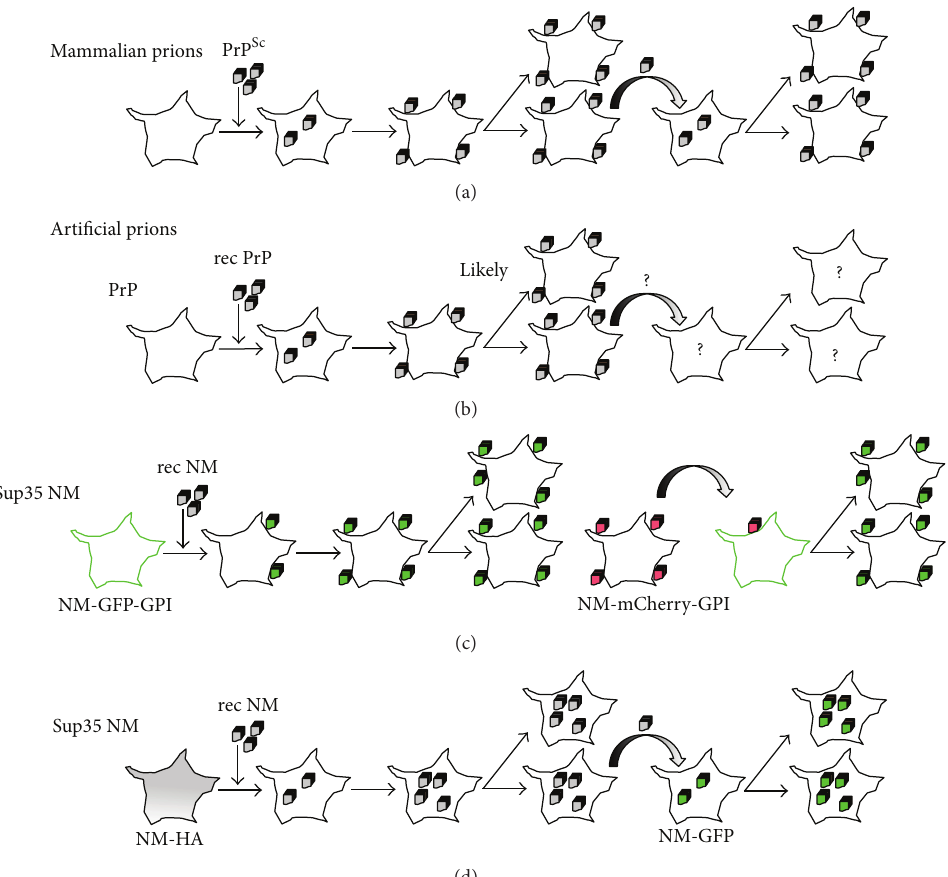
Figure 1: Induction of a PrP or Sup35 NM prion phenotype in mammalian cells. (a) Mammalian prions can infect selected cell cultures. Exposure of permissive cells to brain homogenate containing PrP Sc leads to infection of cells. Prions persist mainly through stable inheritance of PrP Sc aggregates by daughter cells. Prions also spread to adjacent cells by cell-to-cell contact or exosomes and induce productive infection in recipient cells. (b) Artificial prions produced in vitro from recombinant prion proteins. PrP aggregates derived from PrP and minimal components by PMCA are infectious to some cell lines. The increase in PrP Sc over time suggests that prions propagate, likely by vertical transmission to daughter cells. Spreading to adjacent cells has not been studied so far. (c) Recombinant NM fibrils produce a heritable NM aggregation phenotype in N2a cells expressing a GPI-anchored NM-GFP fusion protein. When N2a cells that spontaneously form mCherry-tagged NM-GPI aggregates are cocultured with NM-GFP-GPI expressing cells, they induce NM aggregation in neighboring cells. (d) Cytosolically expressed NM-HA is soluble but can be induced to aggregate upon addition of recombinant NM fibrils. The NM aggregate phenotype is transmitted vertically and